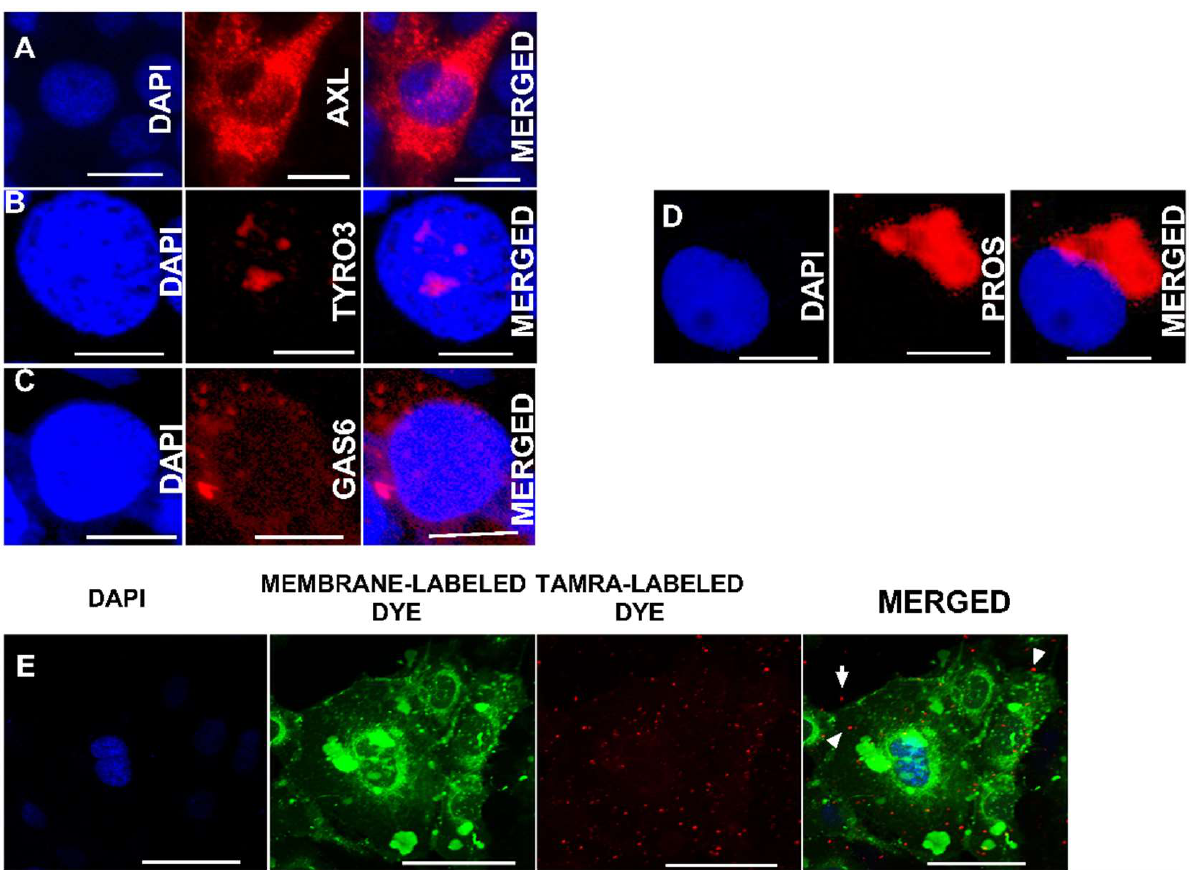
Figure 3. Gas6 and Protein S mediated engulfment of RLW ABs by the AXL-expressing LX2 cells: Immunofluorescent staining of ( A ) Axl receptors, ( B ) Tyro3 receptors, ( C ) Gas 6, ( D ) Protein S, ( E ) Immunofluorescence staining to demonstrate the engulfment of RLW ABs by LX2 cells. RLW ABs were labeled with TAMRA dye and LX2 membranes were stained with cytoplasmic dye (CellBrite ® Cytoplasmic Membrane Dyes, San Francisco, USA). Staining was visualized using 20 × lens of a Keyence BZ-X810 fluorescence microscope. Pictures are of representative data from three independent experiments.